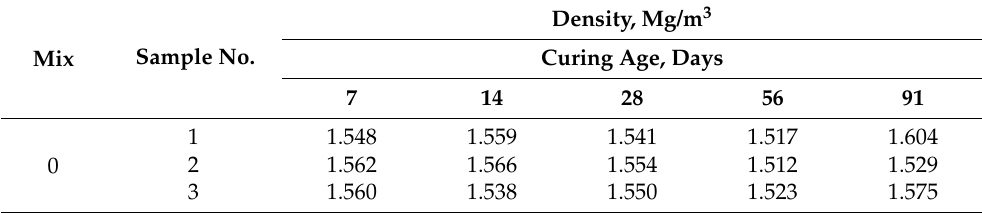
Table 11. Results of density measurement of samples from the different considered pozzolanic- concrete mixtures at different curing